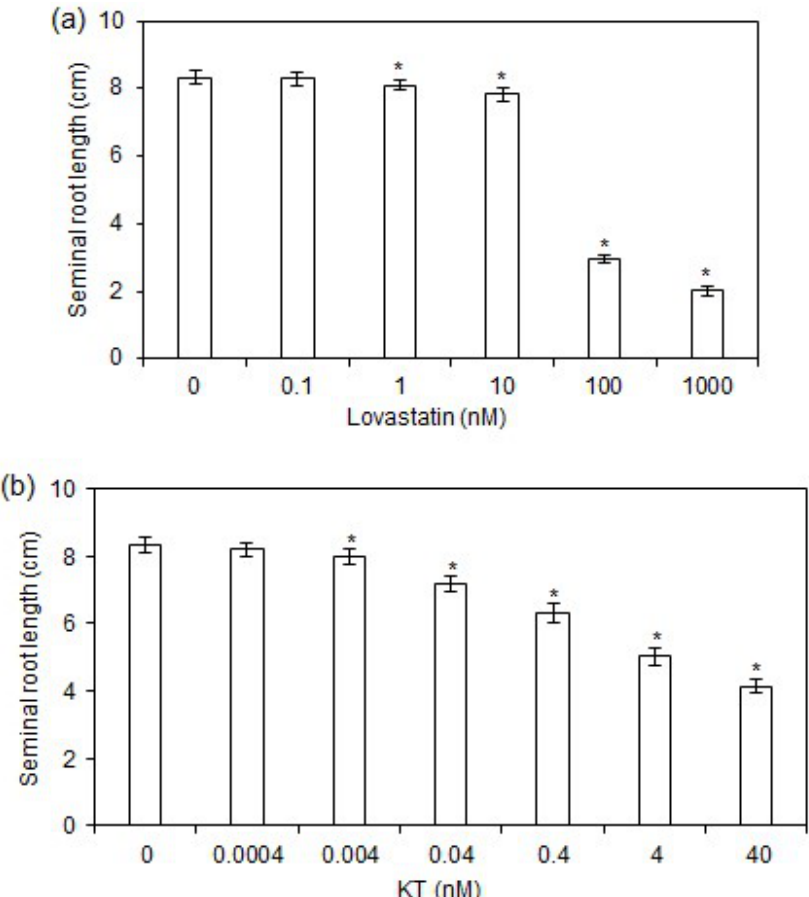
Figure 1. Dose-response curves of seminal root growth inhibition by exogenous lovastatin and kinetin (KT). Germinated rice seeds were incubated with a solution of lovastatin, KT, or distilled water as a control. The lengths of seminal roots were measured after 4 days of growth in experimental treatments. ( a ) Dose effects of lovastatin on rice seminal root growth. ( b ) Dose effects of KT on rice seminal root growth. Data are presented as means ± standard error (SE) calculated from nine biological replicates. Asterisks indicate significant differences ( p < 0.05) between control and experimental treatments.